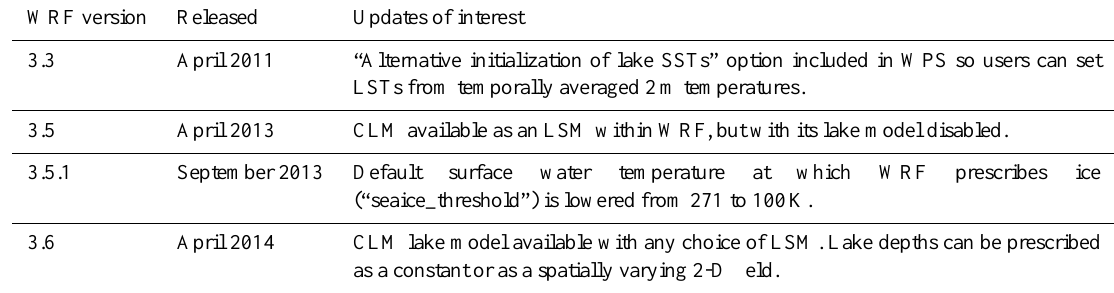
Table 1. List of WRF versions discussed in the text, ordered chronologically by the date of release and with relevant model updates summa- rized.